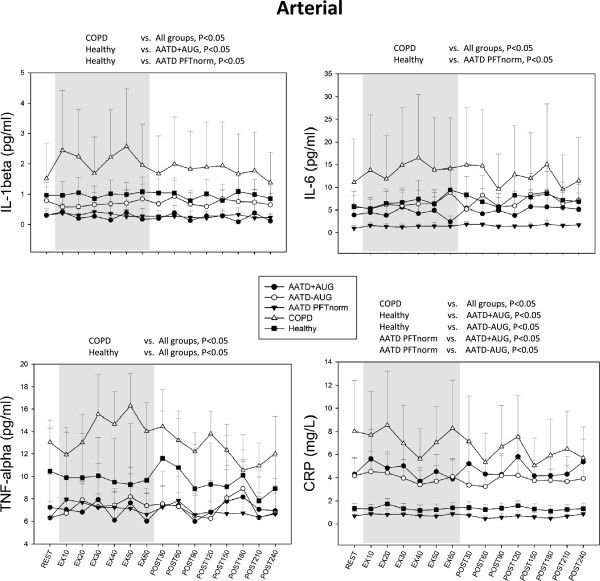
Arterial serum levels of IL-1β, IL-6, TNFα and CRP obtained under resting conditions (black bar), every 10 minutes during 1-hour single-leg knee extensor exercise at 50% of maximal exercise capacity (gray bars), and every 30 minutes (up to 4 hours) during recovery post exercise (white bars), in COPD individuals with alpha-1 antitrypsin deficiency receiving augmentation therapy (AATD + AUG), AATD individuals not receiving augmentation therapy (AATD-AUG), AATD individuals with normal pulmonary function (AATD PFTnorm), non-AATD COPD patients (COPD), and age-/activity-matched controls with no lung disease (Healthy). Significant ANOVA main effect for group differences are shown above each graph. In all cases, significance is determined as p < 0.05.